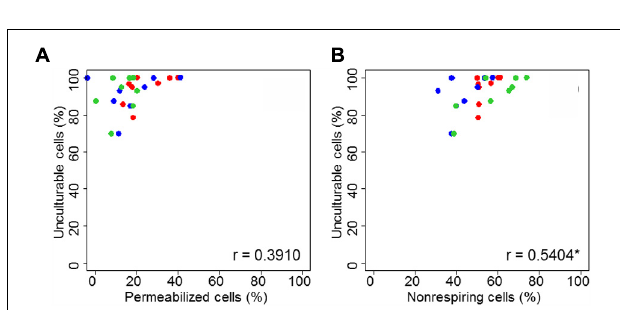
FIGURE 6 | Correlation plot of unculturable bacterial cells during heat treatment in dried state as function of membrane permeability (A) and respiratory activity (B) . Correlation global was proposed for C. sakazakii (red), S. Typhimurium (blue), and S . Senftenberg (green). “c” is the correlation coefficient and the “ ∗ ” indicates if correlation is significant ( p < 0.05), both obtained with Pearson correlation